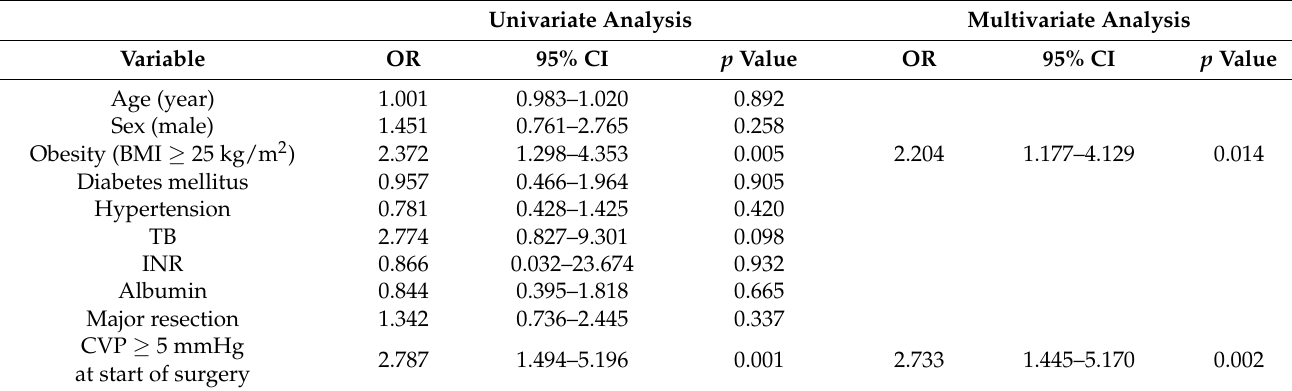
Table 3. Analysis of risk factors for estimated blood loss ≥ 500 mL.